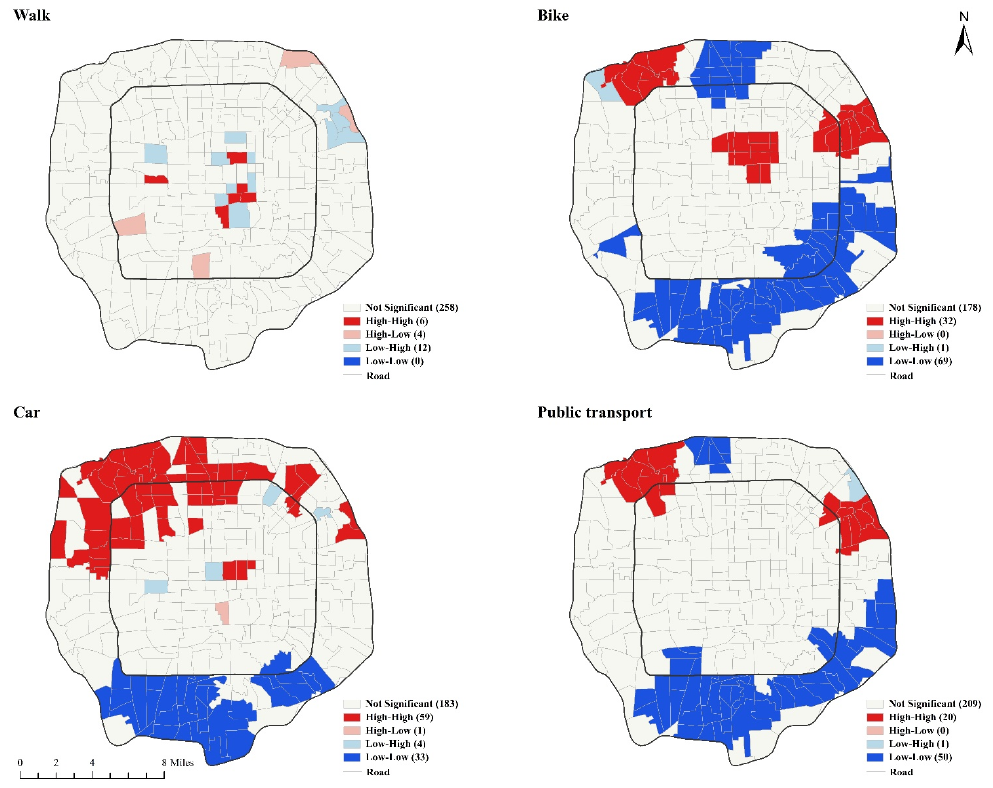
Figure 11. Local indication of spatial association (LISA) cluster map of accessibility index, under four travel modes.